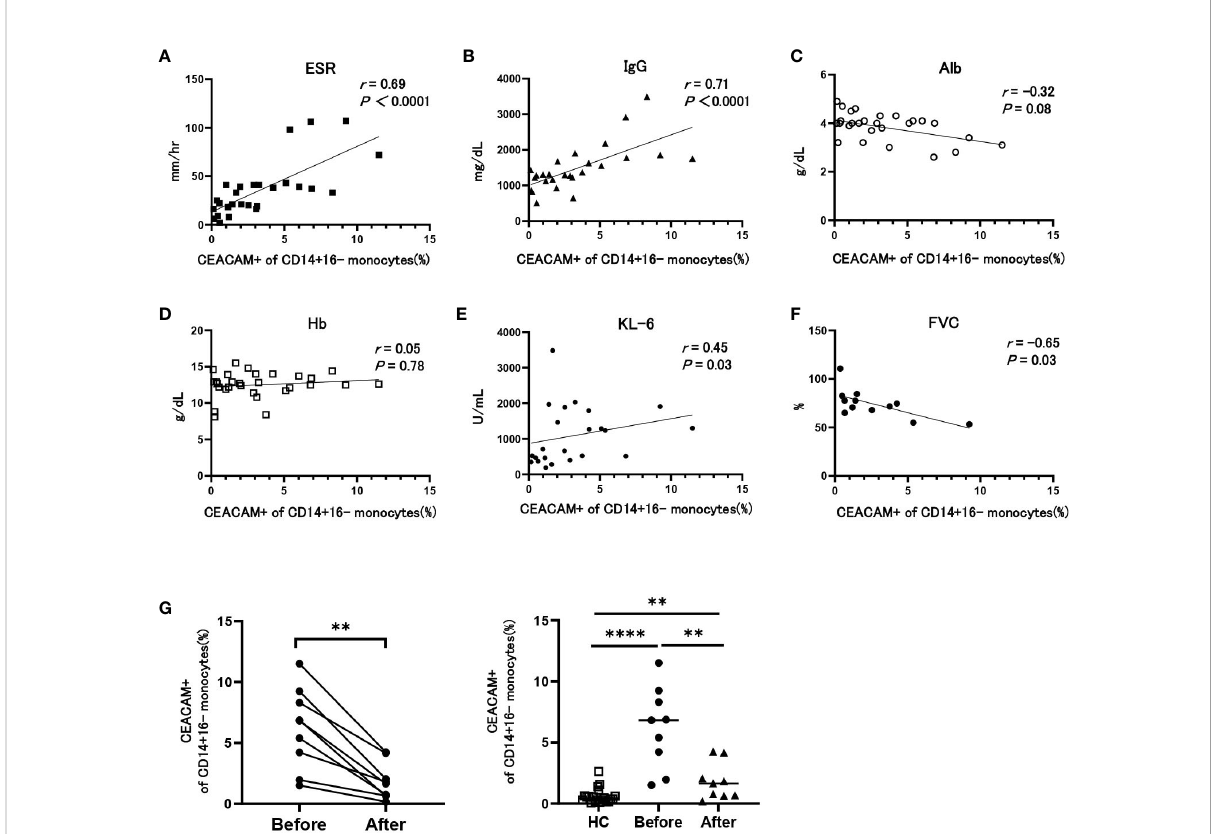
FIGURE 2 The association between the proportion of CEACAM-positive cells in classical monocytes and clinical parameters in patients with SSc. (A-F) Correlation between the proportion of CEACAM+ cells in CD14+16- monocytes and ESR (A) , serum IgG (B) , serum albumin (C) , hemoglobin (D) , serum KL-6 (E) , and forced vital capacity (FVC) (F) in patients with SSc. Correlation coef fi cients and P values were calculated using Spearman ’ s rank correlation test. (G) The proportion of CEACAM+ cells in CD14+16- monocytes before and after immunosuppressive therapies in patients with SSc (n=8) and HCs. P values were calculated using a Wilcoxon matched pairs signed rank test. The right fi gure shows comparisons of the proportion of CEACAM-positive monocytes between HCs and SSc patients before and after therapy with immunosuppressant. P values were calculated using a Mann – Whitney U test. ** P < 0.01, **** P <